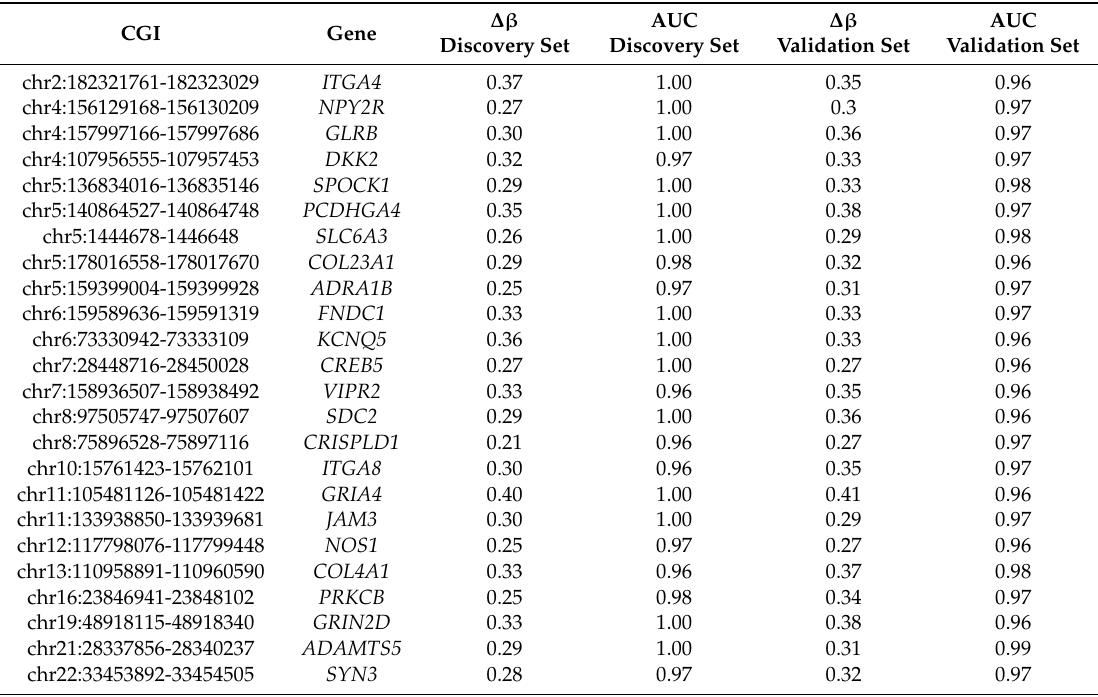
Table 1. Selected CpG islands showing an area under curve (AUC) > 0.95 in our discovery set and in TCGA-COAD validation set. CGI Gene